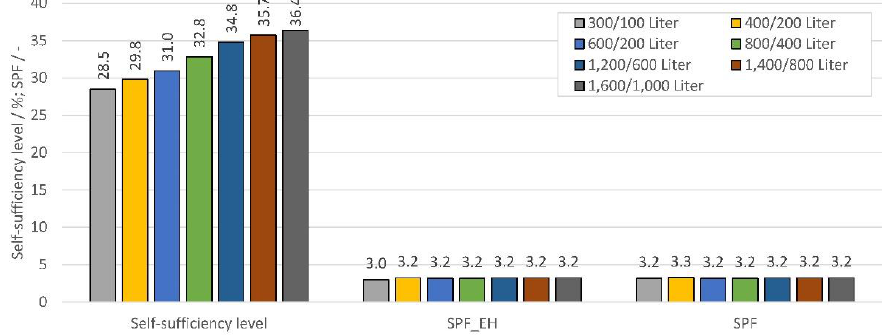
Figure 3. Results of the thermal energy storage (TES) volume variation for SFH category 1